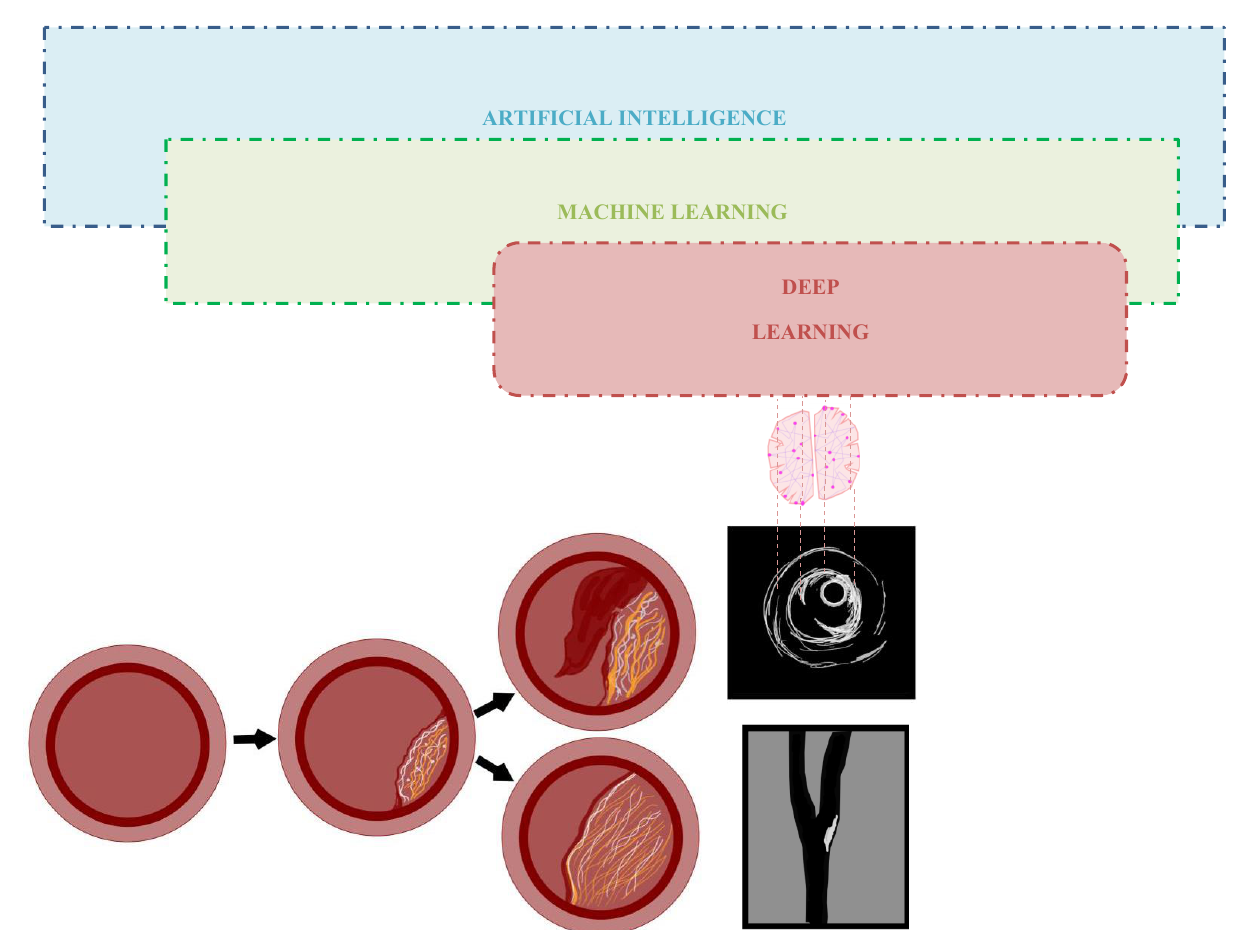
Figure 2. Artificial intelligence and imaging techniques for symptomatic plaque detection. Atherosclerotic plaque’s evolution is expressed by two major terms “stenosis” and “vulnerability”. These two possible scenarios can be detected thanks to several diagnostic imaging tools. Images can be acquired and elaborated by deep learning patterns, which could make image interpretation faster and more accurate, overcoming some human bias.